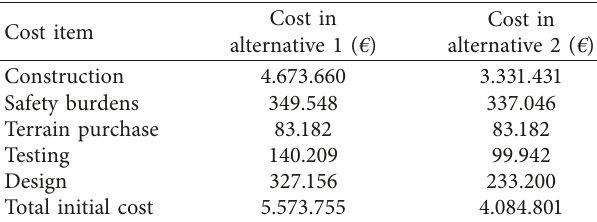
Table 3: Initial costs of the two design alternatives for the